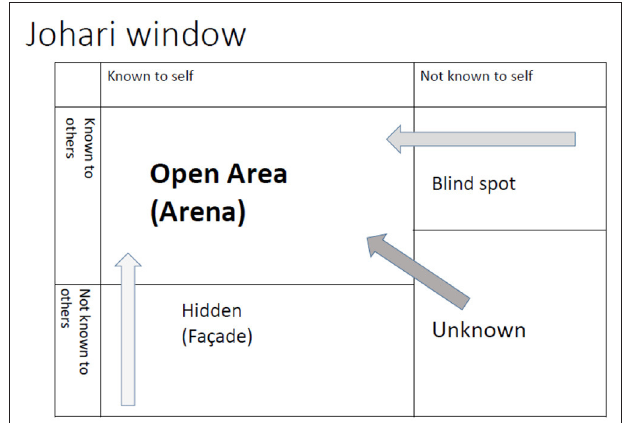
FIGURE 5 | Johari Window with enlarged